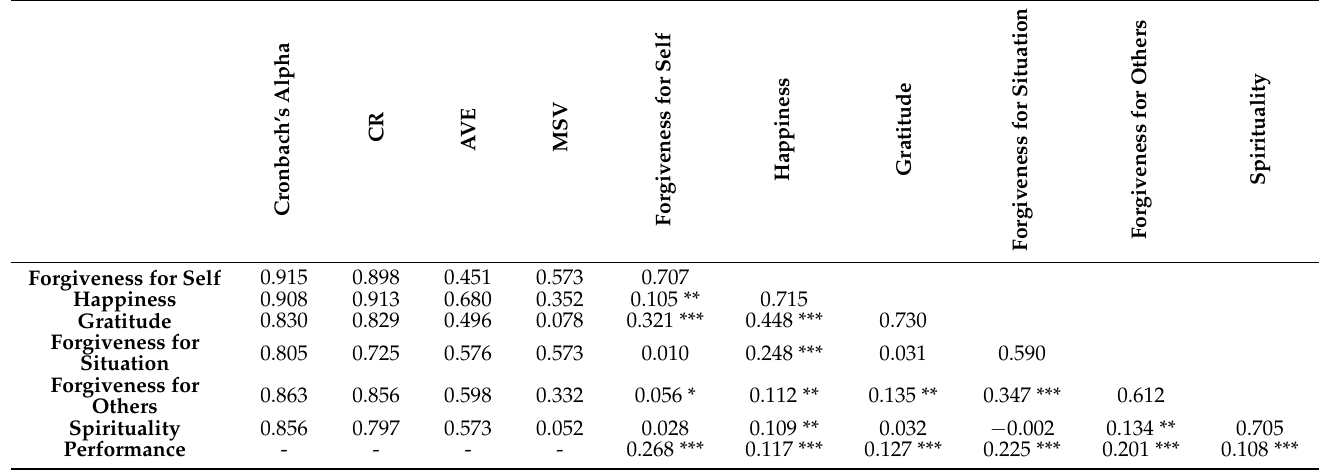
Table 1. The inter-construct correlations, reliabilities, and validity statistics of time 1.